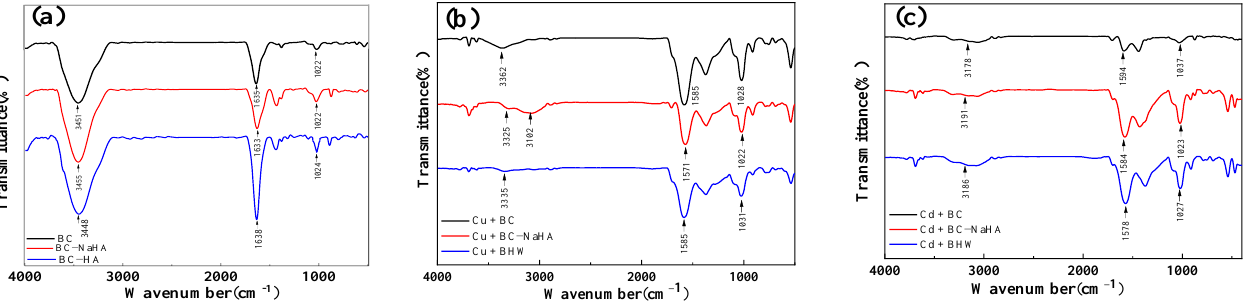
Figure 6. ( a ) FT-IR spectra of Cu 2+ ions immobilized by BC, BC−NaHA, and BHW; ( b ) FT-IR spectra of Cu 2+ ions immobilized by BC, BC-NaHA, and BHW; ( c ) FT-IR spectra of Cd 2+ ions immobilized by BC, BC−NaHA, and BHW .